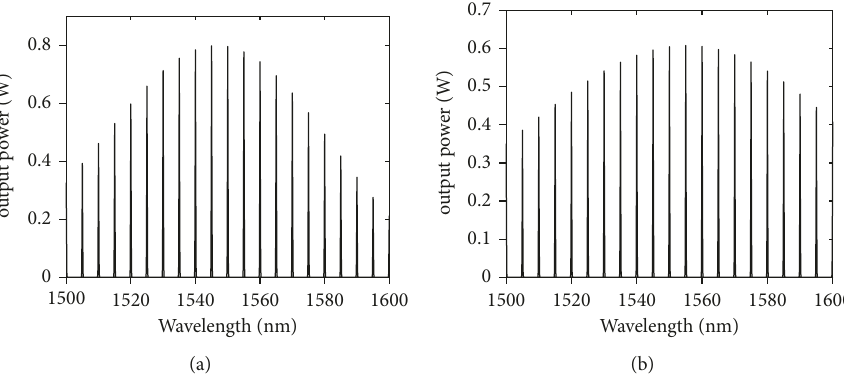
Figure 6: Change of output power with wavelength. (a) Configuration 1. (b) Configuration 2.